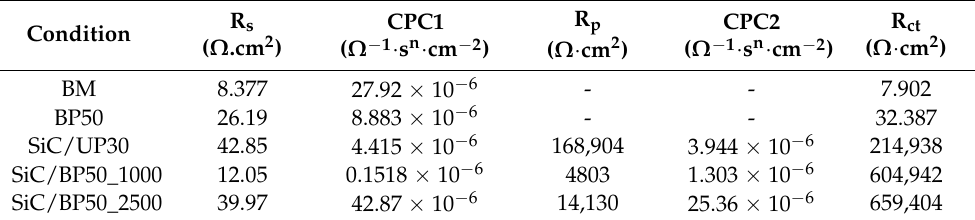
Figure 7. Equivalent circuit models for ( a ) AA20214BM and ( b ) PEO-coated samples. Table 4. EIS fitting results of the AA2014 studied conditions in 0.5 M NaCl